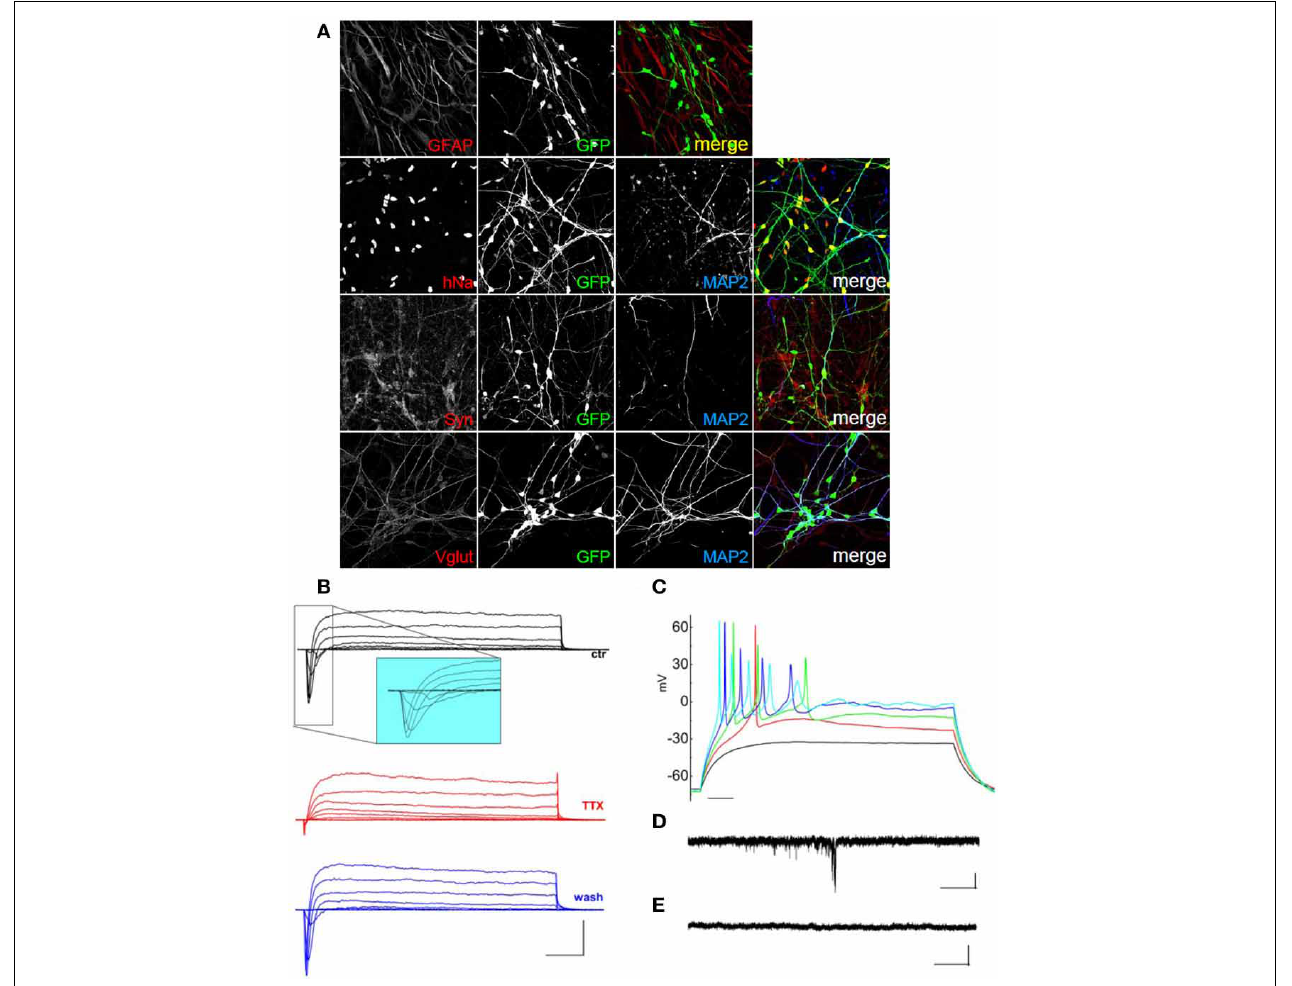
FIGURE 4 | Characterization of hNP-derived neurons differentiated by co-culture on rat glial cells. (A) hNP-derived neurons are positive for hNA (red; top, left) and MAP2 (blue) and for the mature neuronal markers synaptophysin (red, middle, left) and VGLUT (red, bottom, left). Scale bar, 50 μ m. (B) Representative total ionic current traces recorded with depolarizing voltage steps between − 70 and + 10mV (10mV increments from a holding potential of − 70mV) from hNP-derived neurons. From top to bottom: currents in control (black), with perfusion of tetrodotoxin 1 μ M (red) and after washout (blue). Scale bars, 10ms, 500pA. The inset shows an enlargement of the traces in control, for